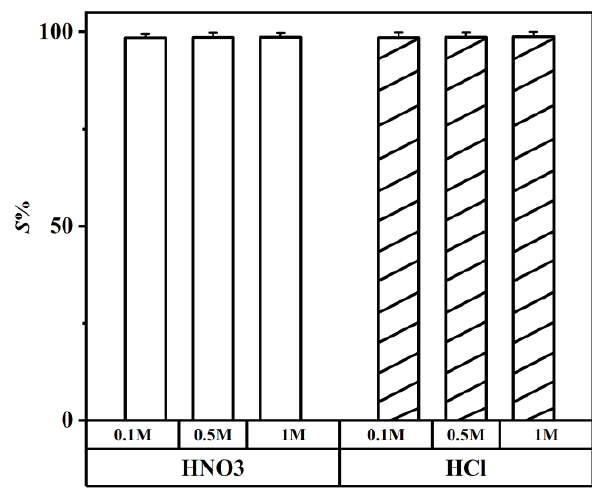
Figure 12. Different concentrations of HNO 3 and HCl for stripping Li + from the metal-loaded DES extractant (molar ratio: HTTA/TOPO = 2/1). The initial concentration of Li + was 25 ppm. Aqueous phase: organic phase = 4:1.